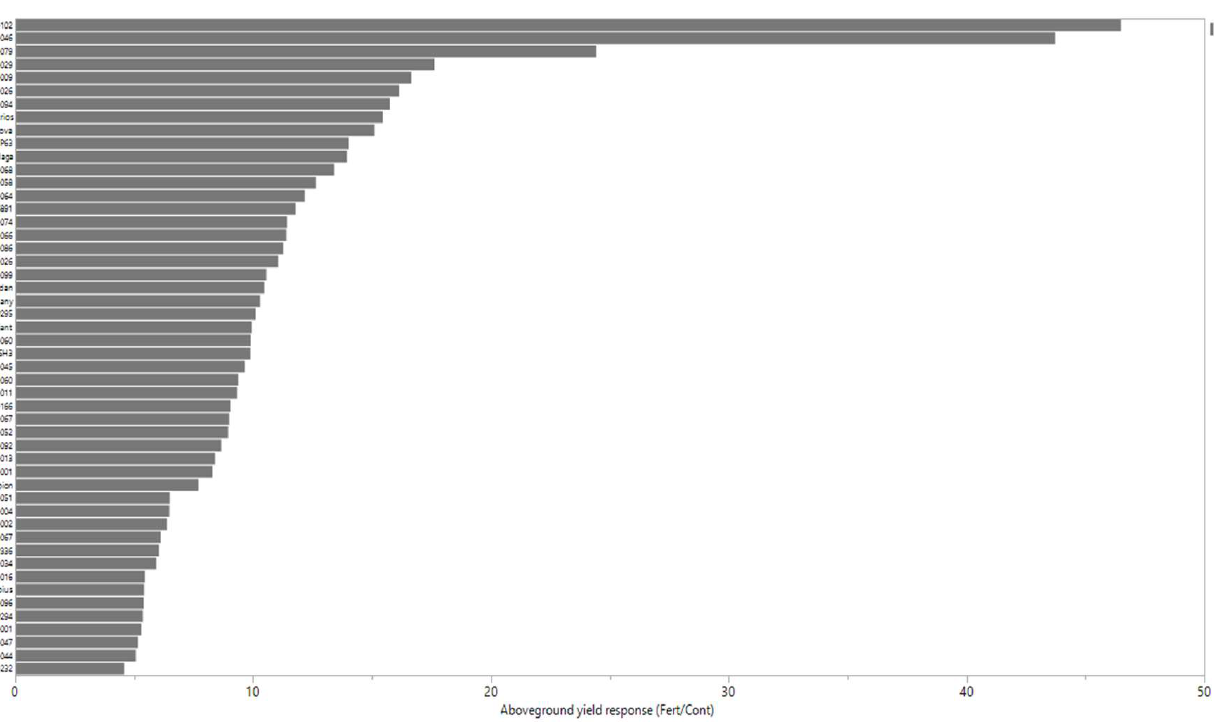
Figure 5. Analysis of biomass-increase among genotypes in aboveground yield response to excess fertilization.